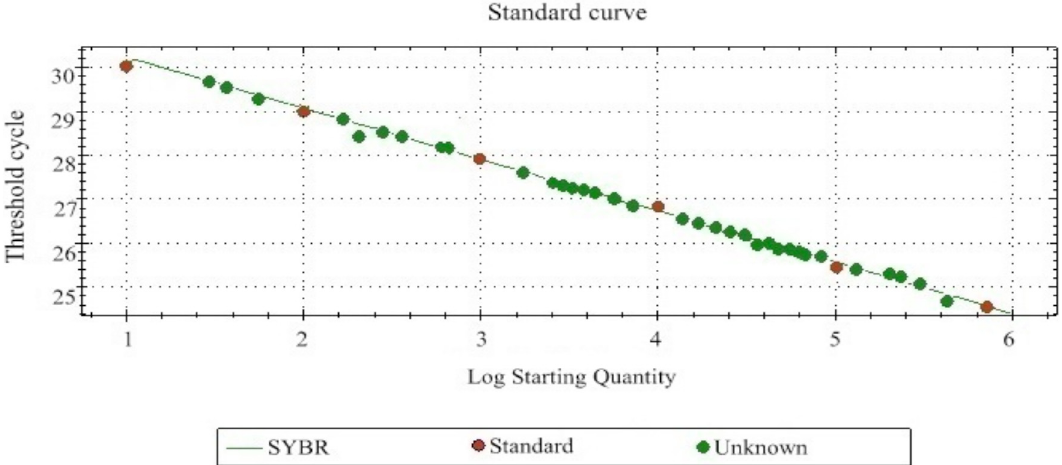
Fig. 4. COI standard curve for across a six-fold dilution series of gDNA from M. rosenbergii